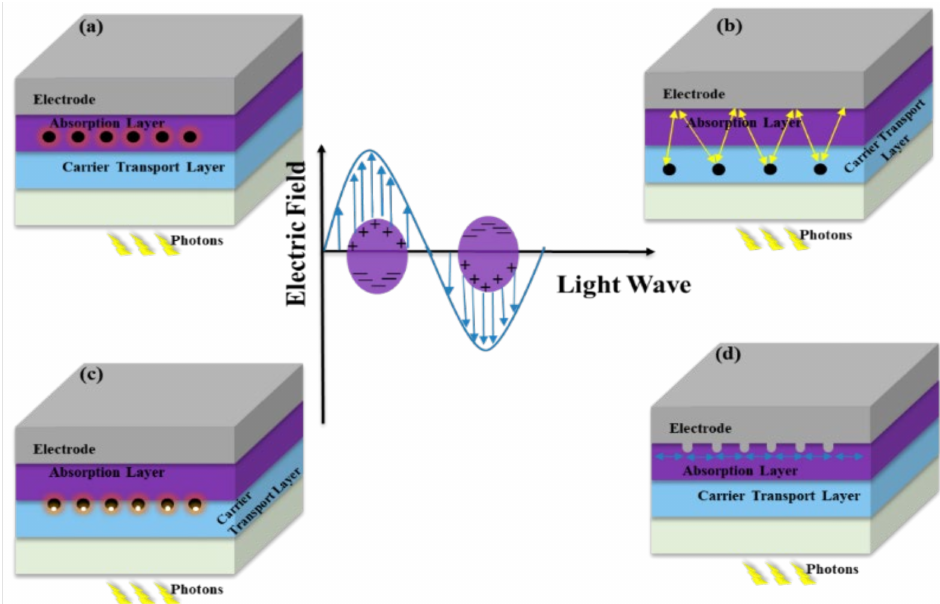
Figure 8. The graph in the middle explains the LSP mechanism in metallic NPs. Structural design of solar cells with plasmonic metallic nanoparticles. ( a ) LSPR enhancement by embedding nanoparticles in the absorption layer; ( b ) embedding nanoparticles for trapping light via the forward scattering effect in the charge carrier transport layer (CTL); ( c ) nanoparticles in the CTL that induced the enhancement of the electromagnetic field in the photoactive layer via the LSPR effect; ( d ) light trapping by the excitation of surface plasmon polaritons (SPPs) at the metal–semiconductor interface (nanostructured metal films placed on the back surface of a solar